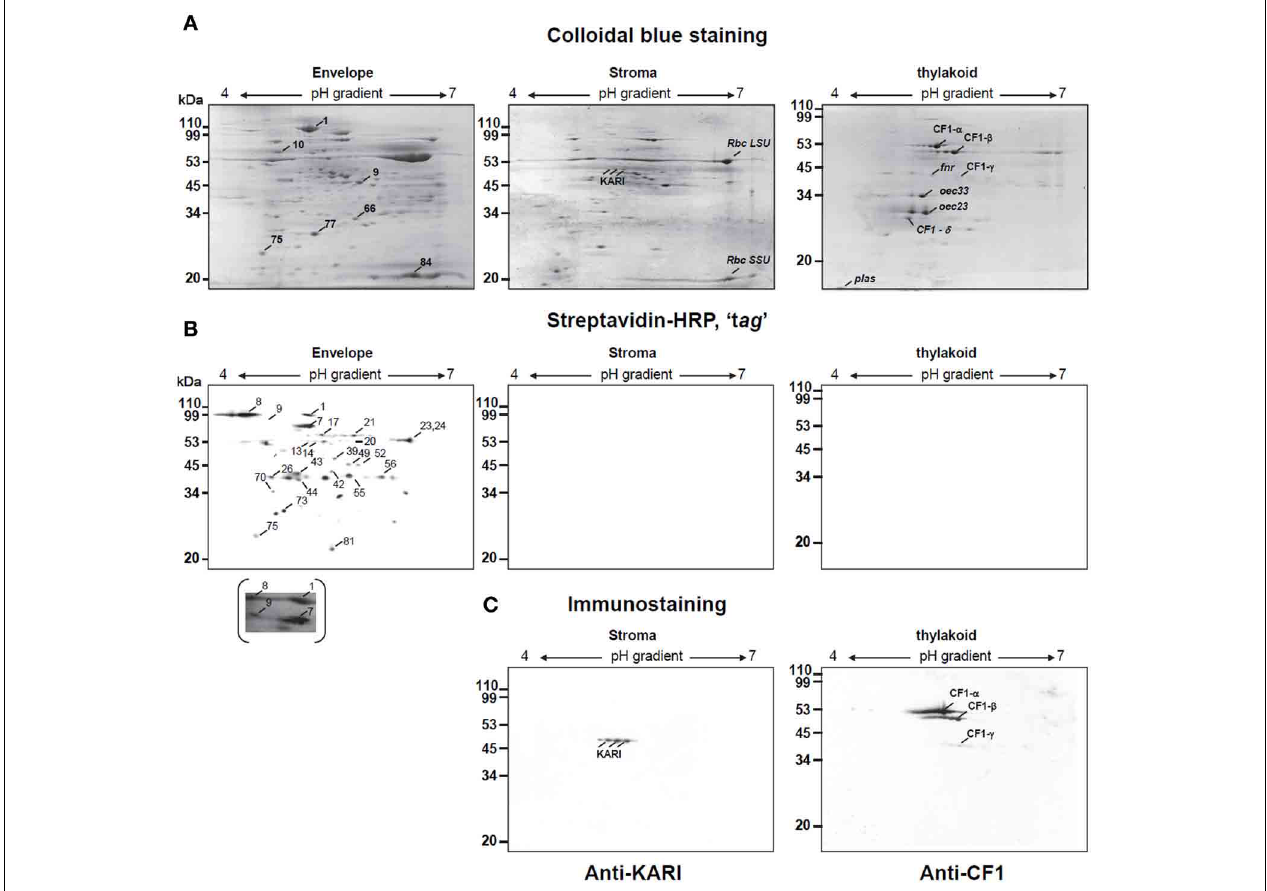
FIGURE 3 | Two-dimensional analysis of biotinylated proteins of envelope, thylakoid, and stroma from spinach chloroplast. Chloroplast envelope (E), thylakoid (T), and stroma (S) proteins (200 µ g) prepared from biotinylated spinach chloroplasts were passively loaded into 7cm pH 4–7IPG strips. Second-dimension separation was in 13% SDS polyacrylamide gels. Proteins were either stained with coomassie blue (A) or transferred to nitrocellulose membrane for biotine detection after Streptavidin Horseradish